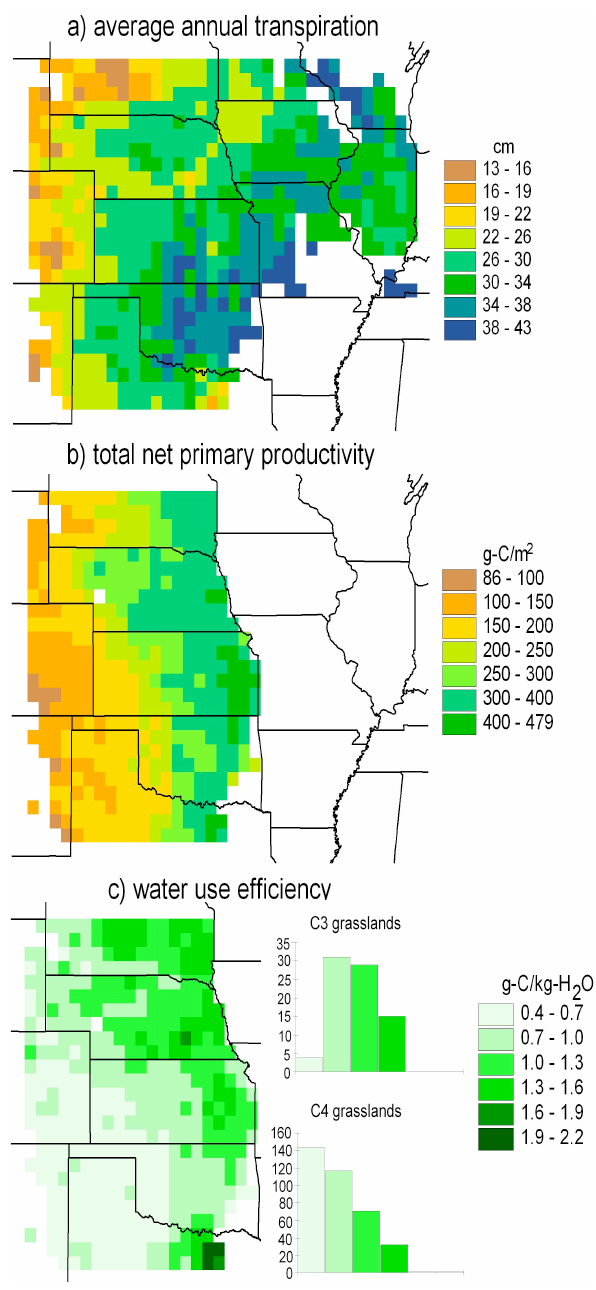
Fig. 12. (a) Modeled average annual grassland transpiration (1951– 1980) for cells in which the natural vegetation is grassland or sa- vanna, (b) estimates of average annual TNPP (1989–1993) from Tieszen et al. (1997) as contained in the database of Zheng et al. (2003b), and (c) water use efficency calculated with (a) and